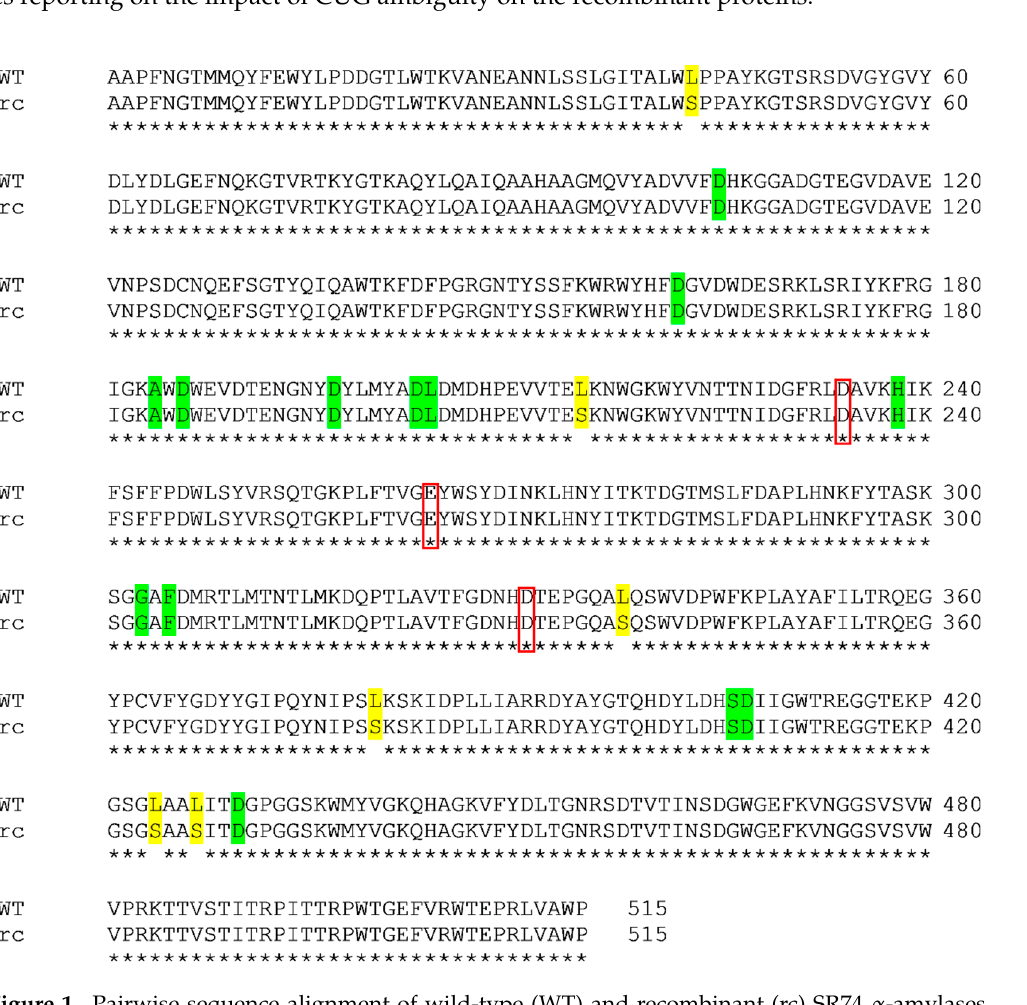
Figure 1. Pairwise sequence alignment of wild-type (WT) and recombinant (rc) SR74 α -amylases. The alignment was performed using Clustal Omega. Six mutation (Leu to Ser) sites were identified and highlighted in yellow. The identity between both proteins was computed as 98.83%. The catalytic triad (D234, E264 and D331) was identified in red boxes. The calcium ion-interacting residues (D105, D162, A184, D186, D197, D203, L204, H238, G303, F305, S406, D407 and D430) were highlighted in green.